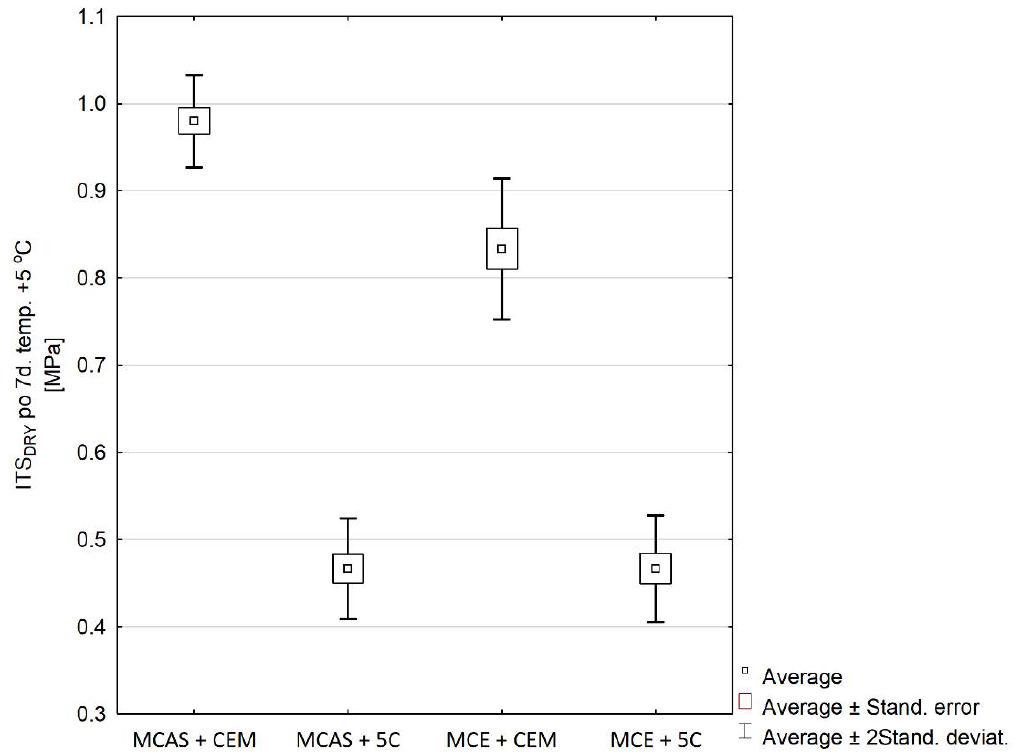
Figure 7. Indirect tensile strength for the MCAS / MCE cold-recycled